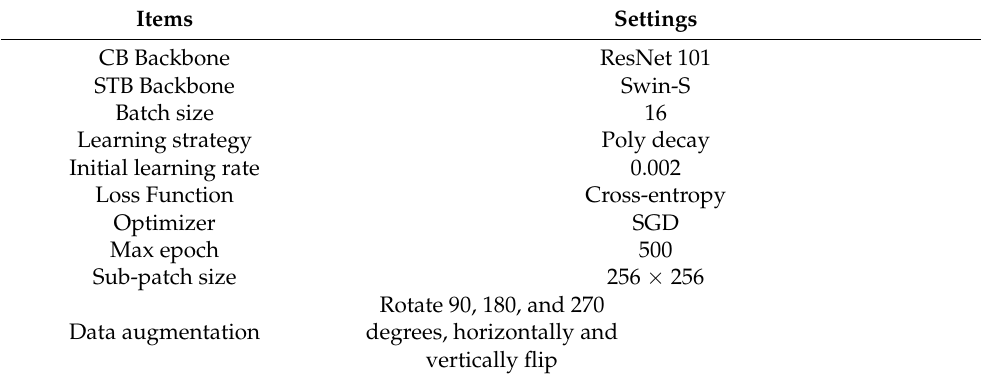
Table 1. Parameter settings.